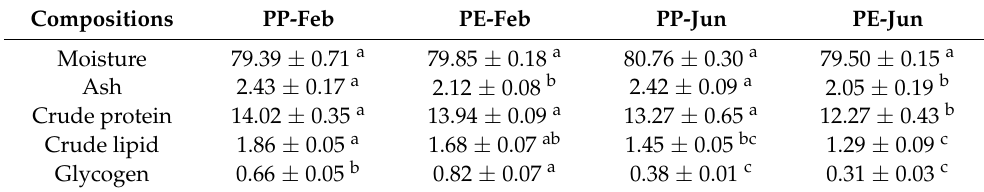
Table 3. Proximate compositions (% wet weight) of two P. f. martensii selective strains at different